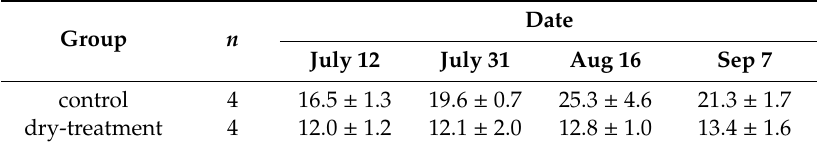
Table 1. Volumetric soil water content (Vol.%; VWC) at 10 cm soil depth for the control and dry treatment groups of T. cordata Greenspire four times in